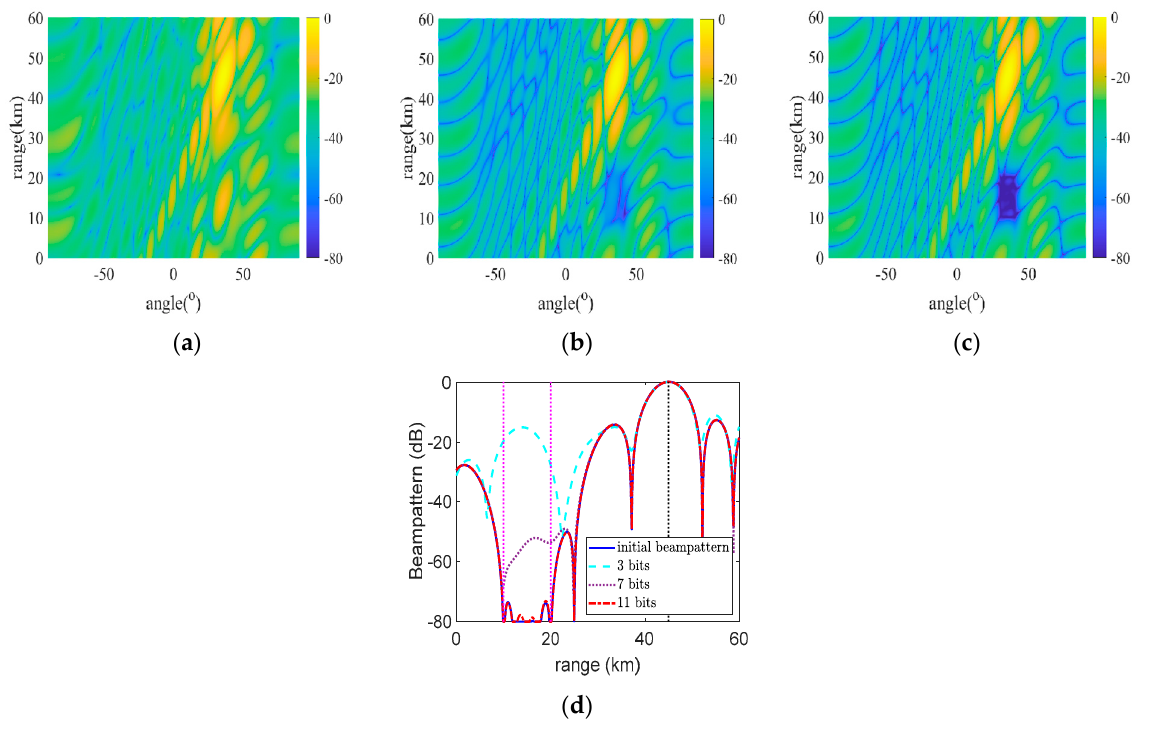
Figure 9. The CMC beampattern on different quantization bits: ( a ) 3 bits, ( b ) 7 bits, ( c ) 11 bits, ( d ) cross–section of different quantization at target angle.